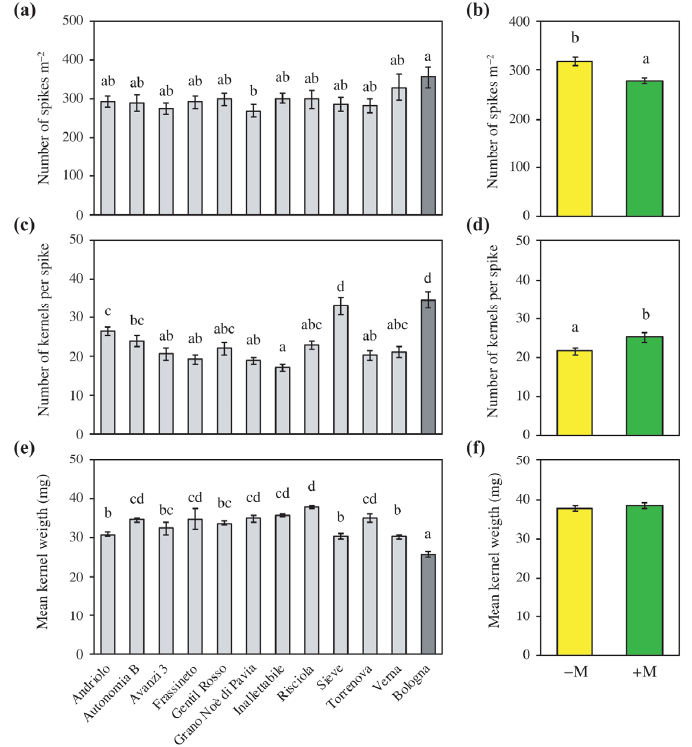
Figure 5. Effects of wheat genotype and AMF inoculation on number of spikes per m − 2 ( a,b ), number of kernels per spike ( c,d ), and on mean kernel weight ( e,f ). AMF inoculation and mock control are indicated as +M and –M, respectively.